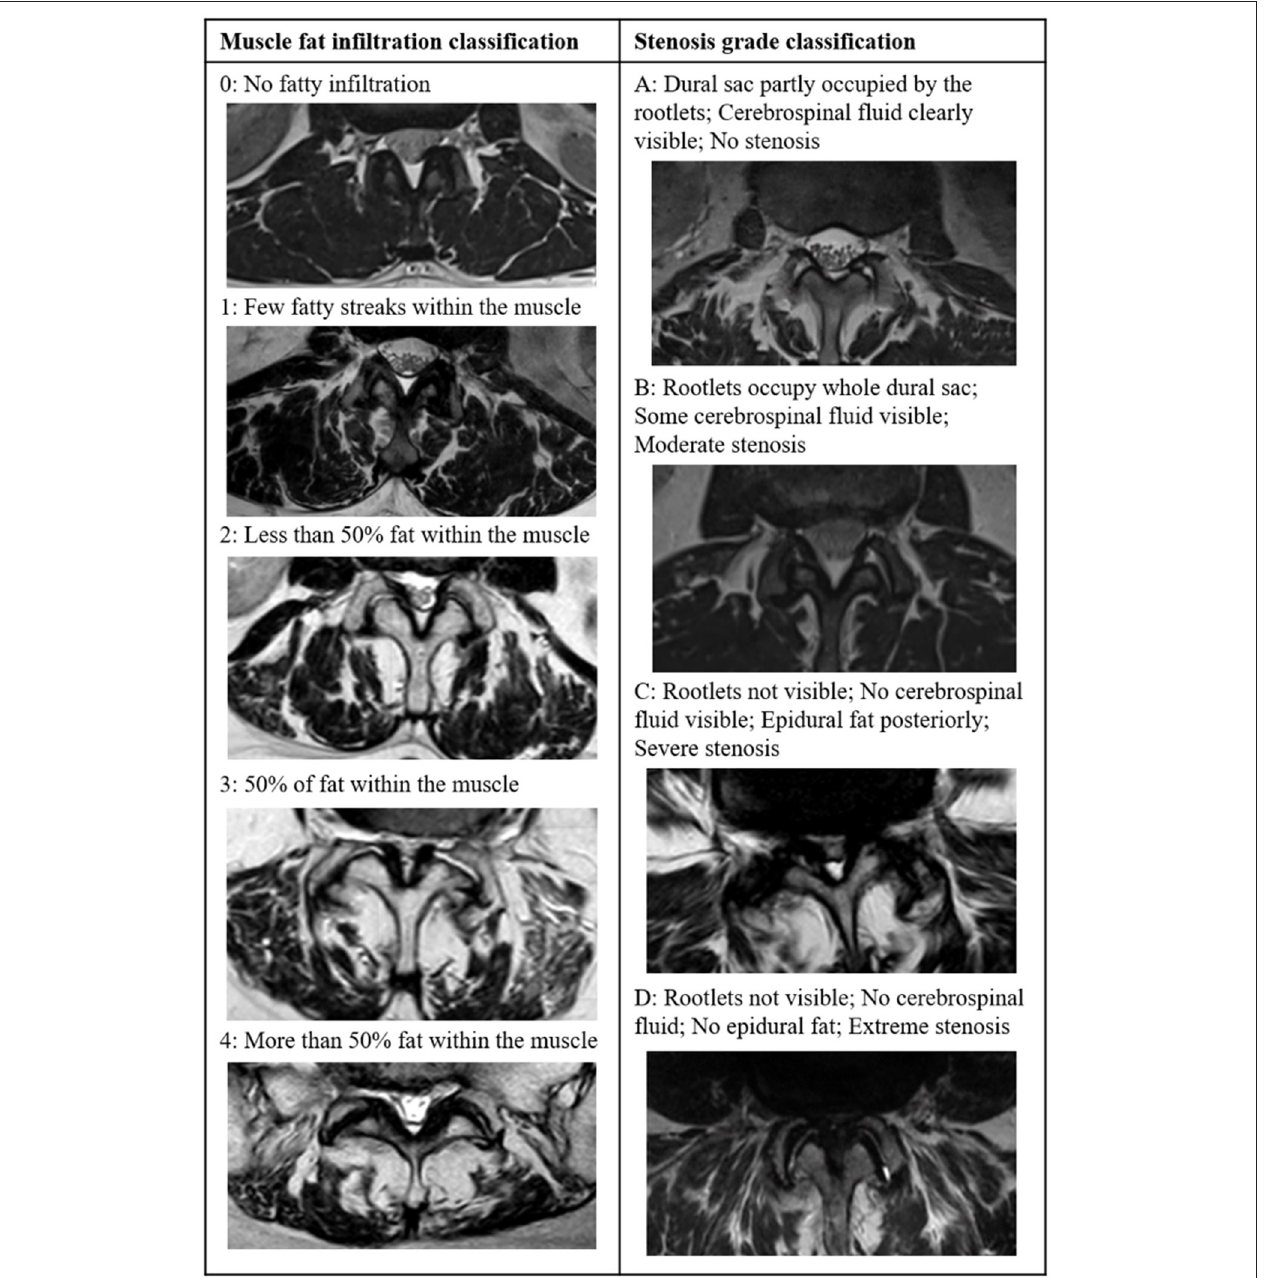
FIGURE 1 | T2-weighted axial images showing the grading of fatty infiltration of paraspinal muscles according to the Goutallier classification (left) (27) and grading of lumbar spinal stenosis according to the Schizas classifications (right)